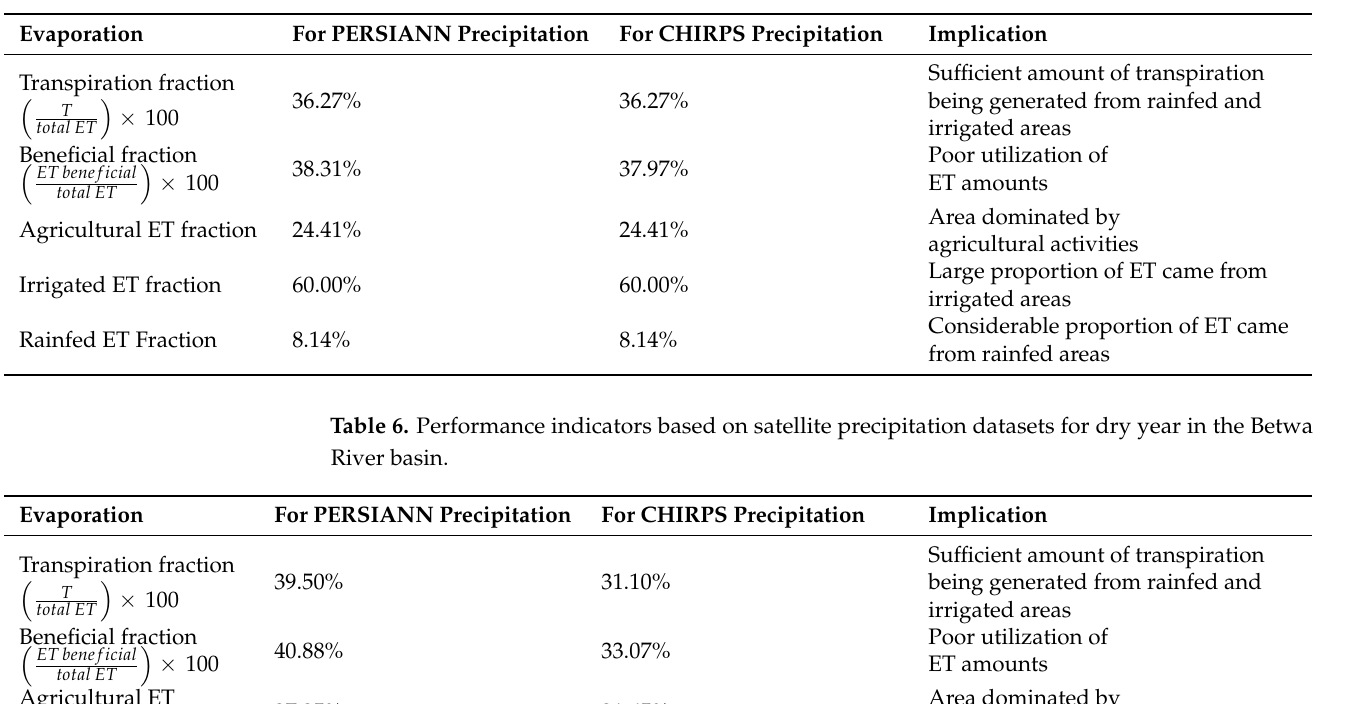
Table 5. Performance indicators based on satellite precipitation datasets for wet year in the Betwa River basin.